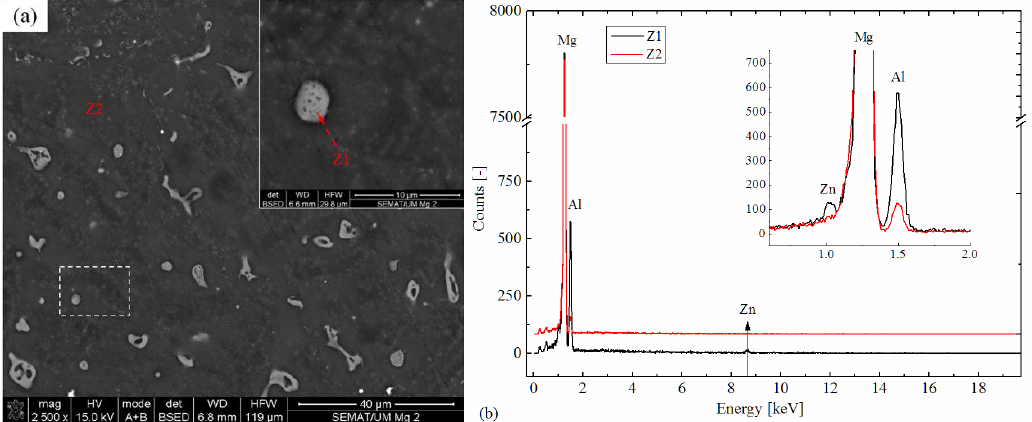
Figure 4. ( a ) Morphology and distribution of the β-Mg 17 Al 12 intermetallic phase in US treated samples; and ( b ) EDS spectrum of the β-Mg 17 Al 12 intermetallic phase.